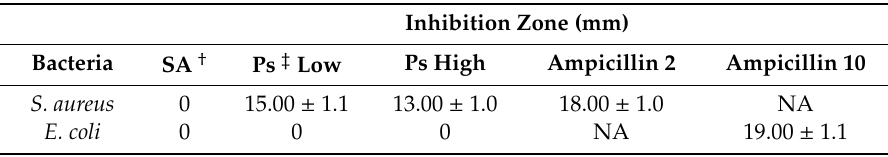
Figure 6. ( a ) The SA without Ps sca ff olds against S. aureus and E. coli after 18 h incubation at 37 ◦ C. ( b ) The inhibition zones of di ff erent Ps concentrations and ampicillin (2 and 10 µ g) against S. aureus and E. coli after 18 h incubation at 37 ◦ C. ( A ): Ampicillin 2 µ g disk (1), Ps low concentration disks (2–4) with S.aureus ATCC ® 29213 ™ ; ( B ): Ampicillin 2 µ g disk (1), Ps high concentration disks (2–4) with S.aureus ATCC ® 29213 ™ ; ( C ): Ampicillin 10 µ g disk (1), Ps low concentration disks (2–4) with E.coli ATCC ® 25922 ™ ; ( D ): Ampicillin 10 µ g disk (1), Ps high concentration disks (2–4) with E.coli ATCC ® 25922 ™ . Table 5. Inhibition zone measurements of S. aureus and E. coli obtained with di ff erent Ps concentrations and ampicillin (2 and 10 µ